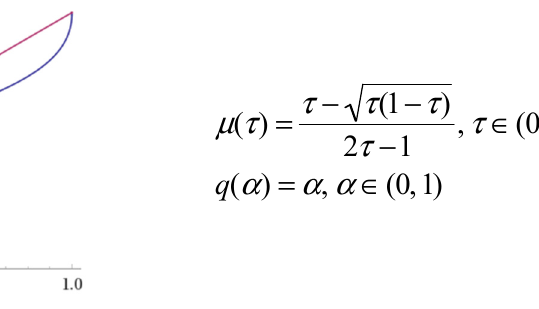
Figure 2. The expectile and quantile functions for the uniform distribution, U (0, 1).